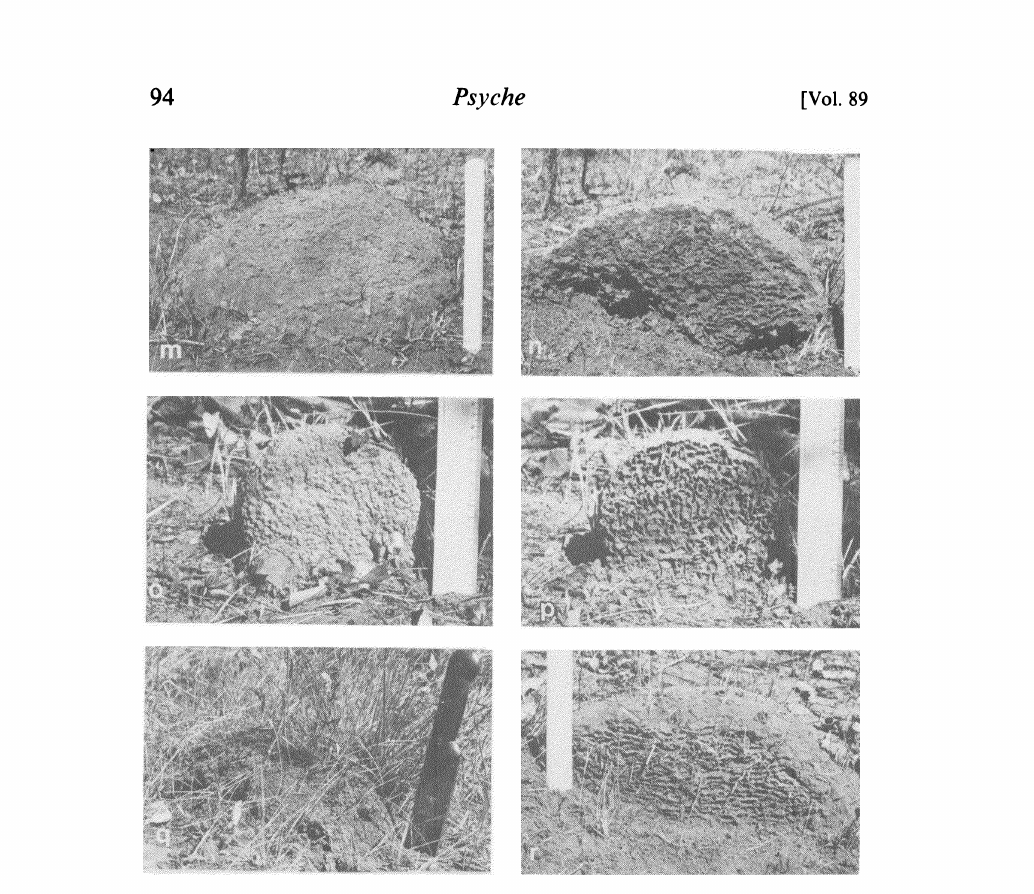
Figure 5. Mounds of the termites species studied; external view and longitudinal section: m and n, Armitermes euamignathus; o and p, Cortaritermessilvestri; q and r, Orthognathotermes